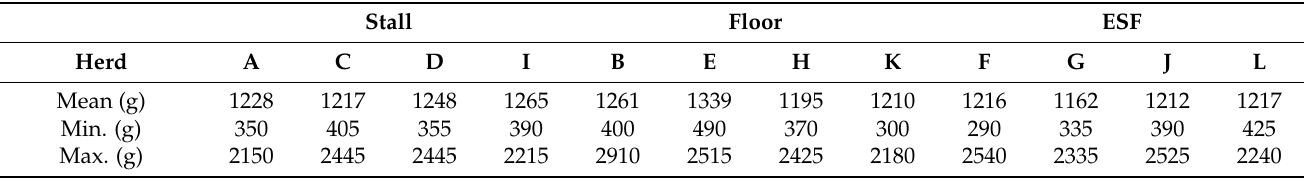
Table 2. Average, minimum and maximum of piglet birth weight at each herd. Stall describes free-access feeding stalls, Floor describes floor feeding and ESF describes electronic sow